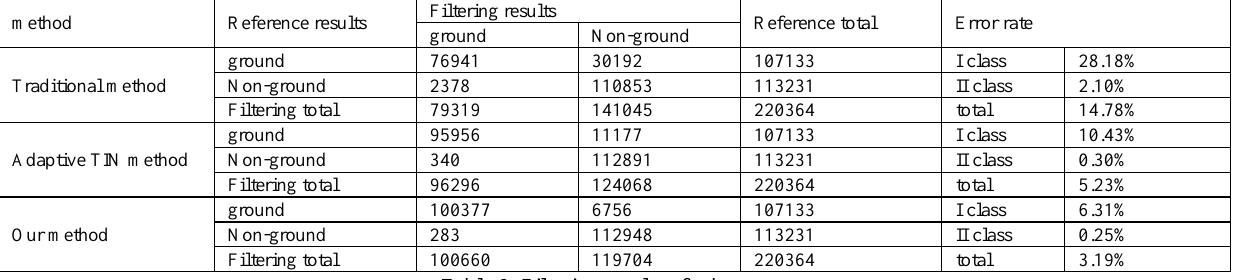
Table 2. Filtering results of urban